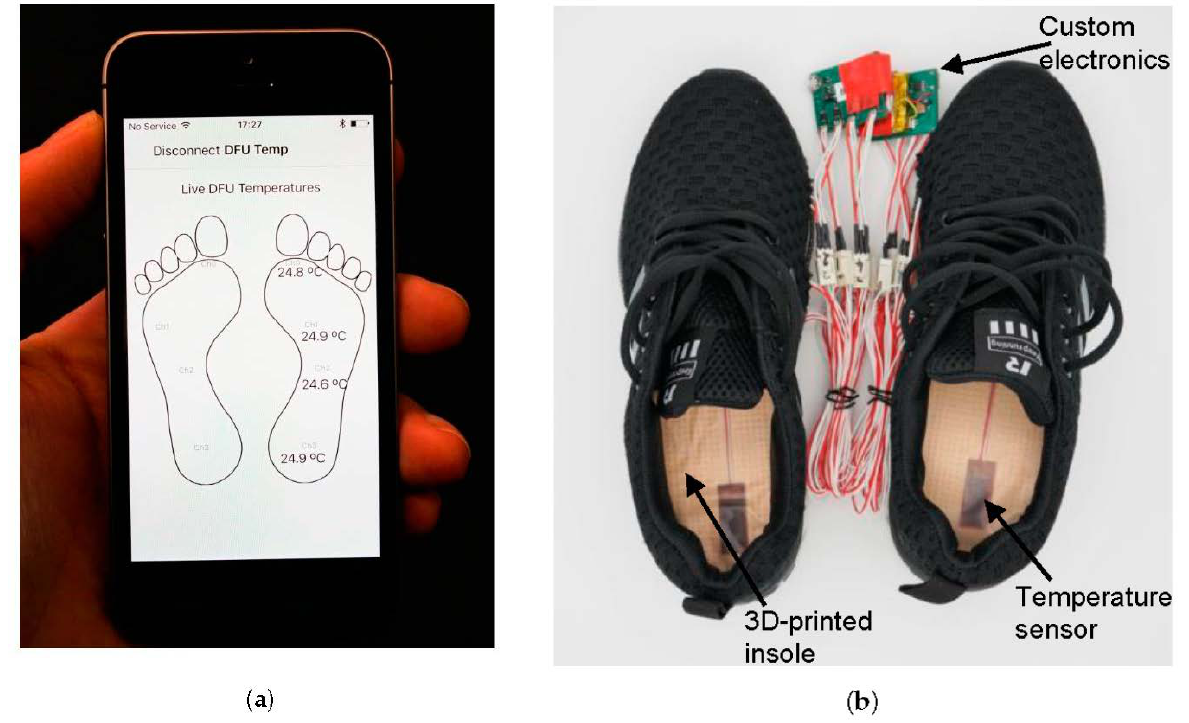
Figure 3. New wearable sensor insole system developed in this work for the continuous monitoring of plantar foot temperatures. ( a ) The iPhone app used for real-time visualisation and logging of data; ( b ) The smart insole system used by participants with the devices fitted inside